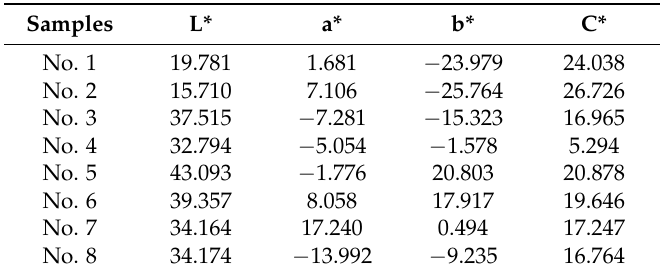
Table 1. L*, a*, b*, C* scale of the samples coated with Al/TiO 2 composite